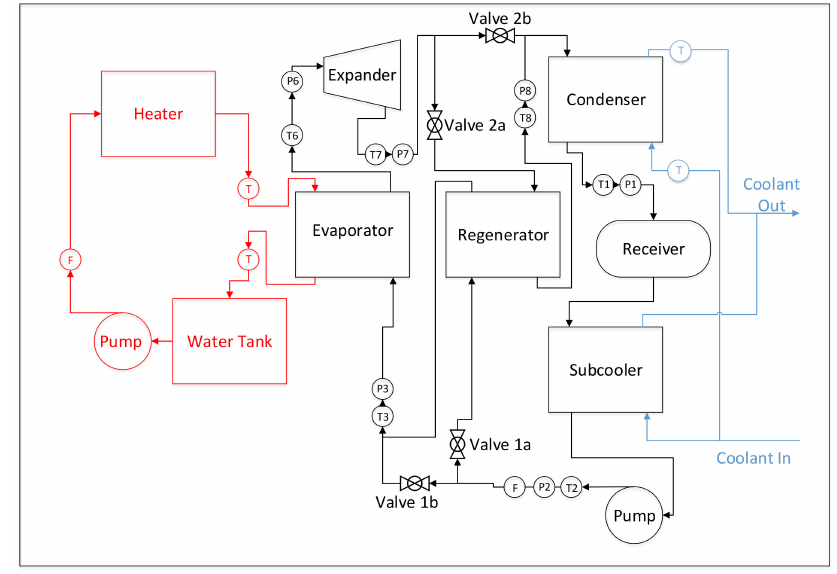
Figure 1. Schematic diagram of the ORC test